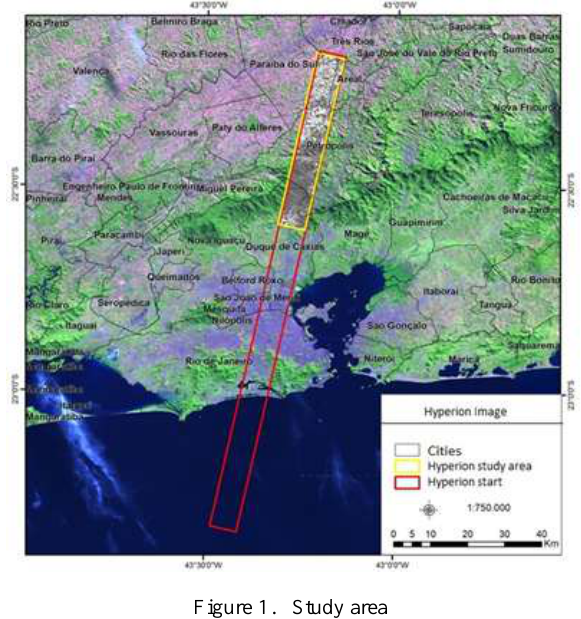
Figure 1. Study area According to Souza (2009) the knowledge about the spectral behavior of vegetation is essential for the correct extraction of different classes from the